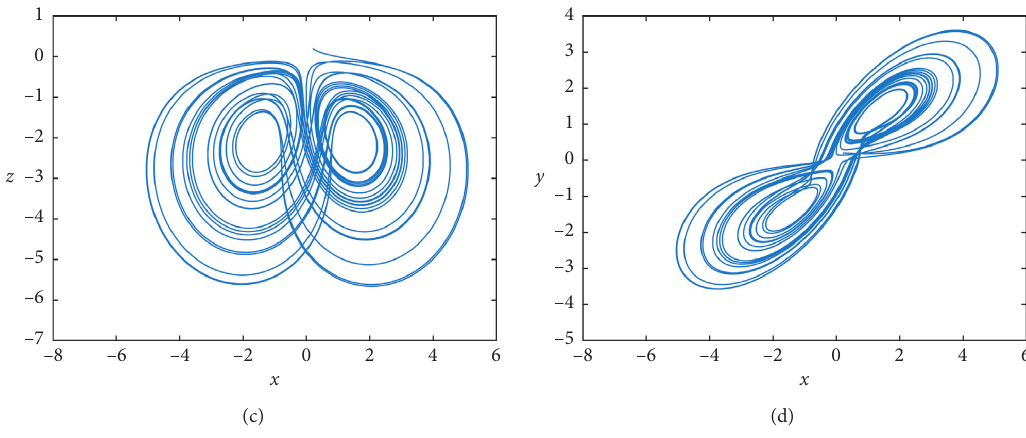
Figure 2: Phase portraits with the order α � 0 .